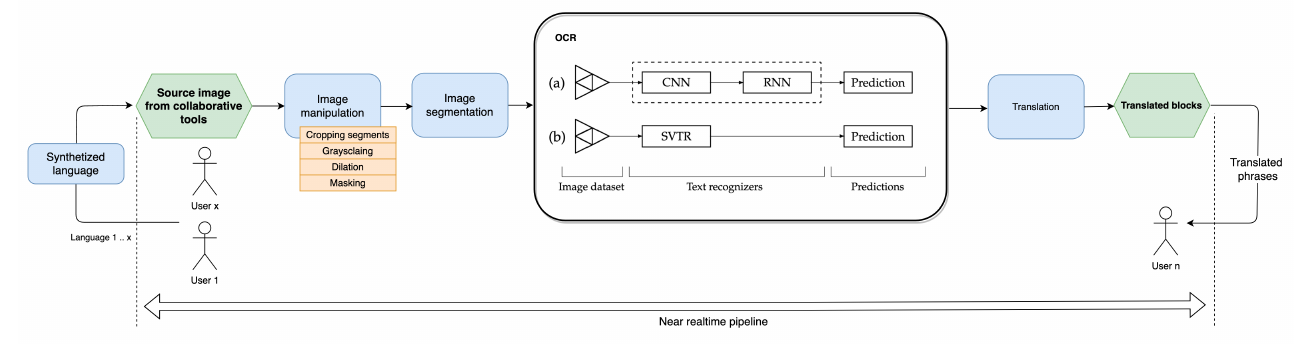
Figure 1. Near real time synthesized language translation pipeline for distant